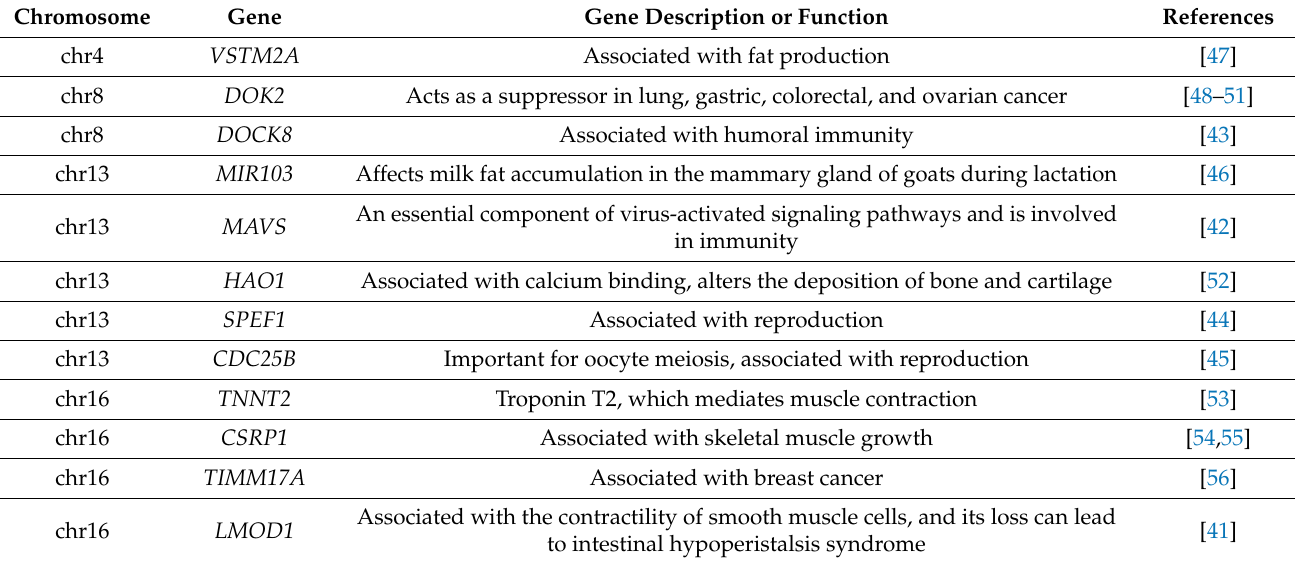
Table 2. Some important genes and their functions identified based on F st and π methods.